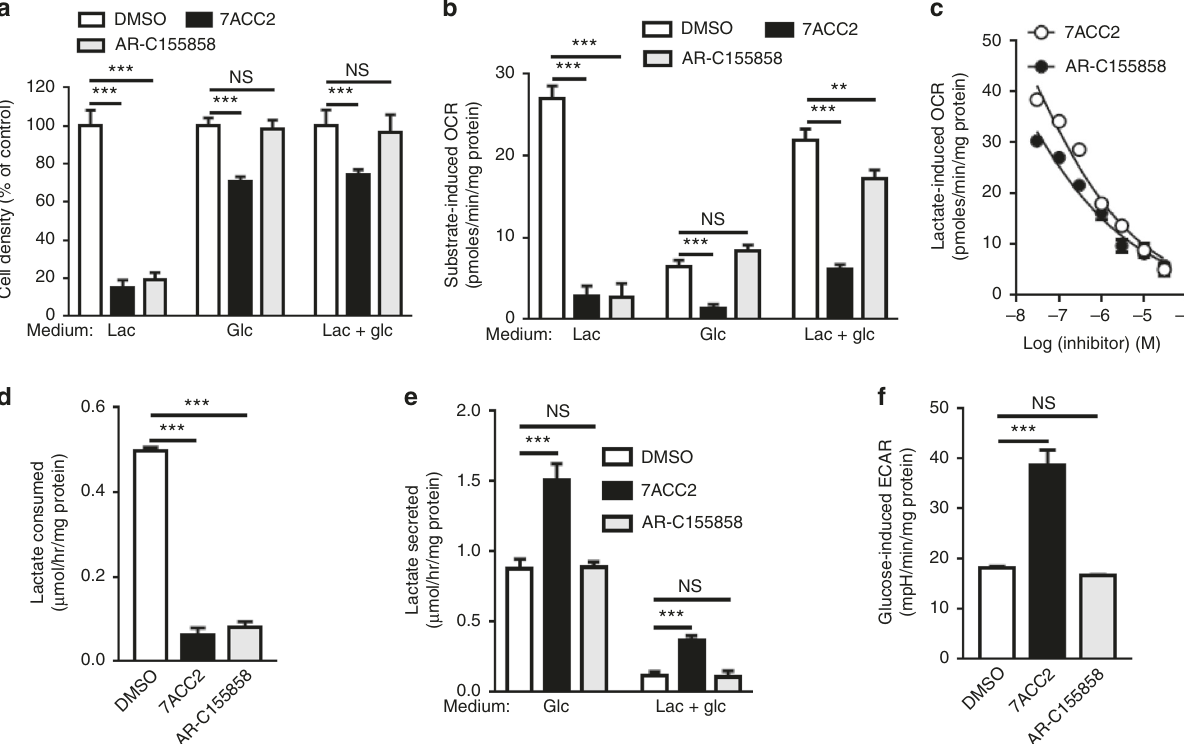
Fig. 1 Inhibitors of lactate metabolism exert differential effects on cancer cell growth and respiration depending on glucose availability. a Cell growth (72 h) and ( b ) oxygen consumption rate (OCR) of SiHa cells after treatment with 10 µ M 7ACC2 or AR-C155858 in media containing lactate (Lac) and/or glucose (Glc). c Lactate-dependent OCR in SiHa cells exposed to increasing doses of 7ACC2 or AR-C155858. d Lactate consumption by SiHa cells incubated for 24 h in a lactate-containing medium. e Lactate secretion by SiHa cells incubated for 24 h in indicated media. f Extracellular acidi fi cation rate (ECAR) of SiHa cells after treatment with 10 µ M 7ACC2 or AR-C155858 for 24 h in glucose-containing medium. Data are represented as mean ± SEM of three independent experiments (with ≥ 6 technical replicates). Signi fi cance was determined by one-way ( d , f ) or two-way ( a , b , e ) analysis of variance (ANOVA) with Bonferroni multiple-comparison analysis. ** p < 0.01; *** p < 0.001; NS, not signi fi